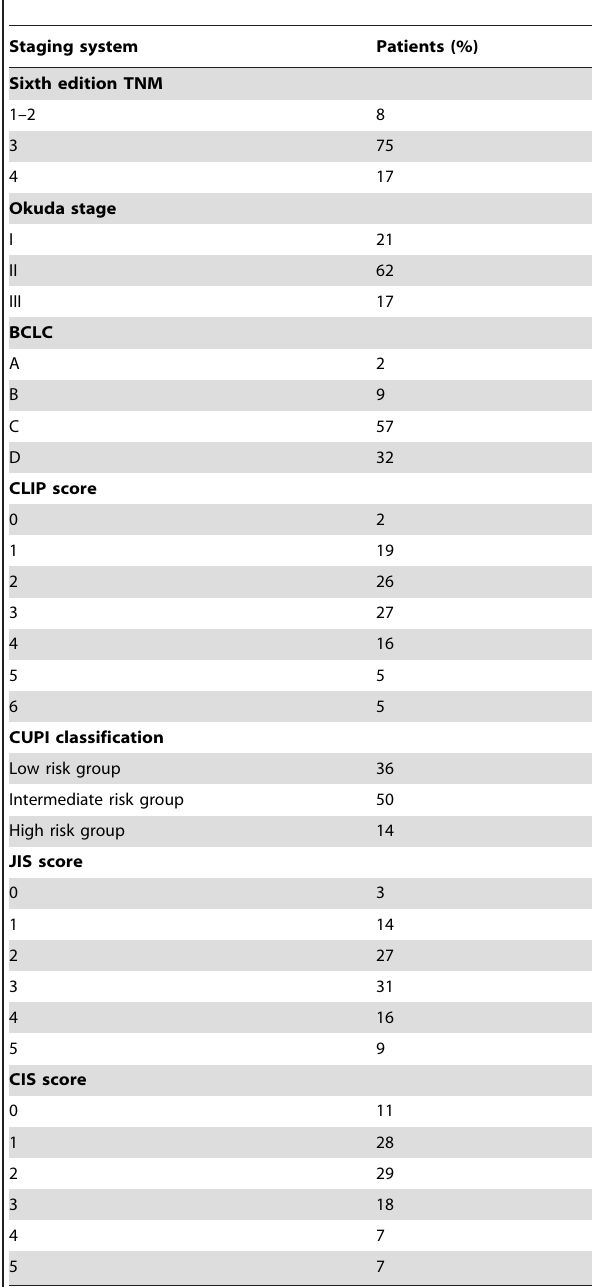
Table 2. Tumor staging information of 196 patients with unresectable HCC.